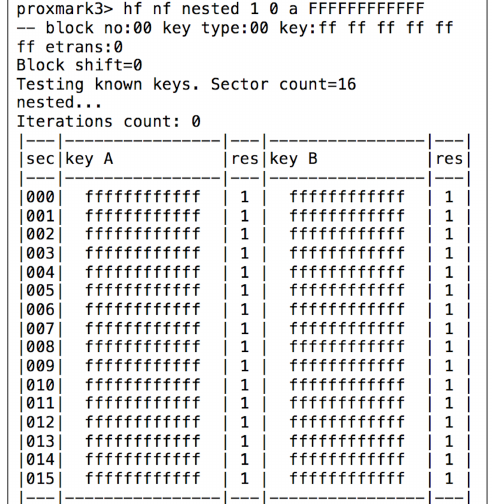
Figure 20. Nested attack for an university RFID